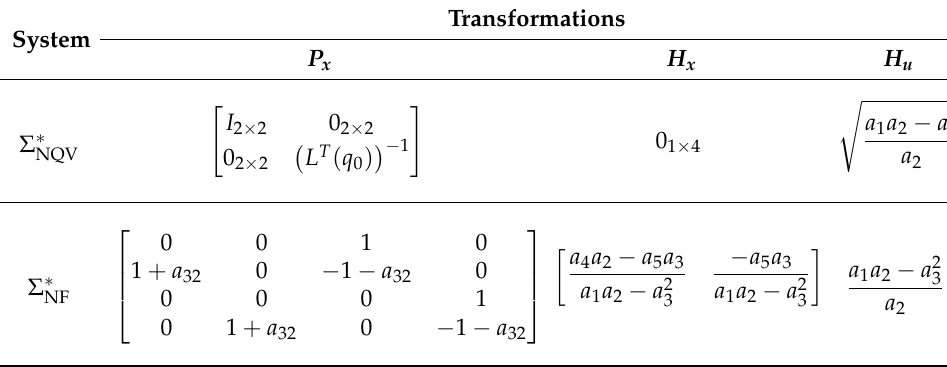
− Equation (14), Σ ∗ NQV